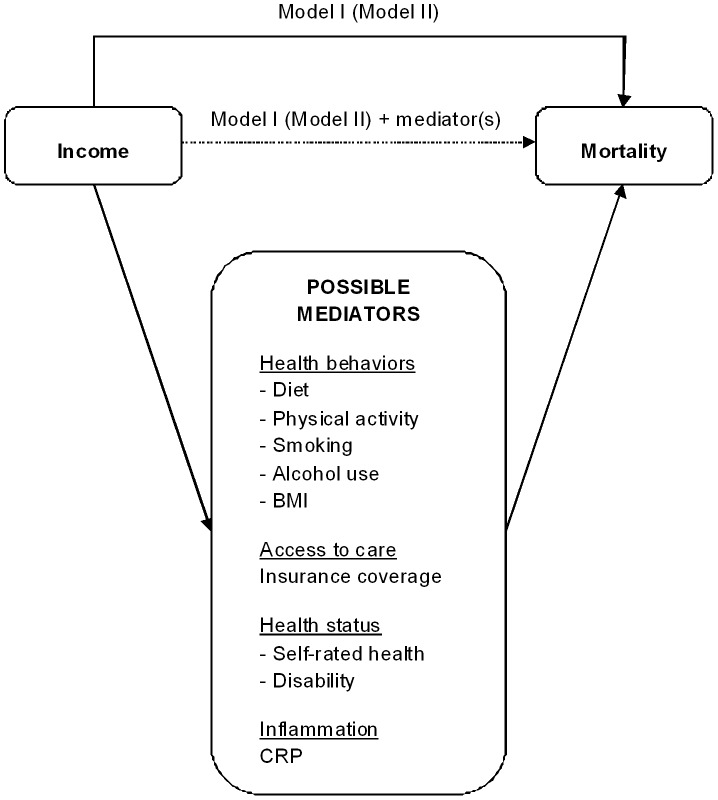
Schematic Diagram of Some Pathways That Mediate the Association Between Income and Mortality.Mediating effect was Calculated as: (β Model I – β Model I+mediator(s)) × 100/β Model I for all-cause mortality (β Model II - β Model II+mediator(s)) × 100/β Model II for CVD/diabetes mortality.